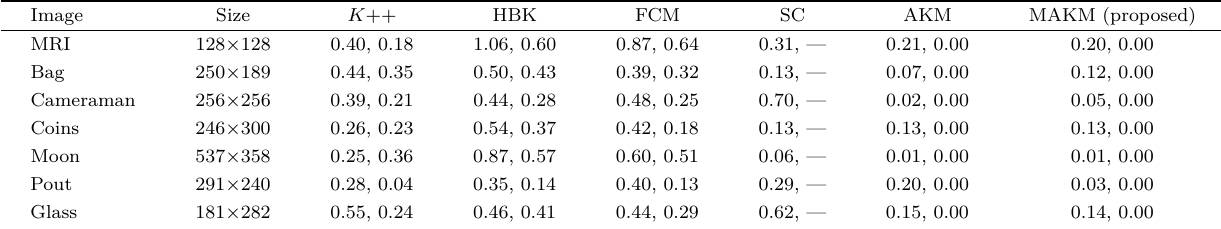
Table 2 Comparison of algorithms in terms of mean Q -value and standard deviation ( Q -value, σ )